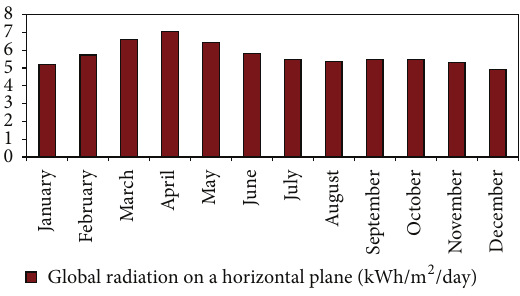
Figure 4: Monthly average daily global radiation.